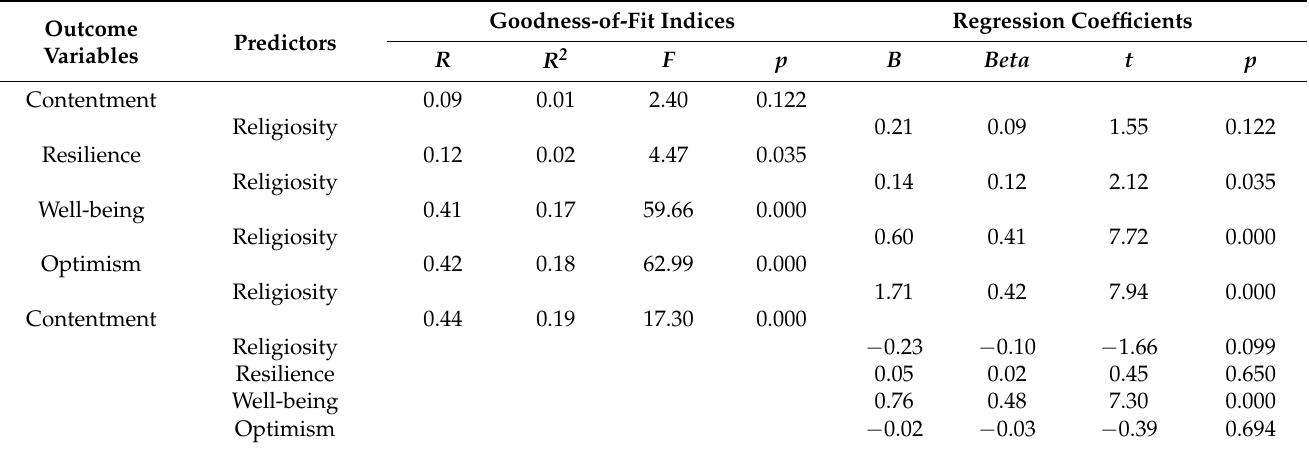
Table 3. Regression coefficients of the mediating